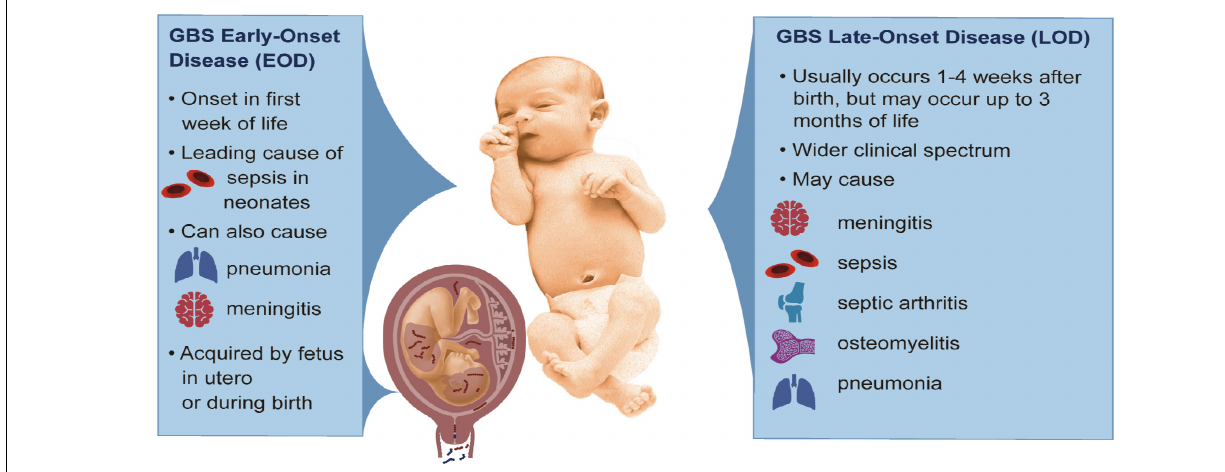
FIGURE 1 | Clinical features of GBS EOD and LOD. The left panel describes characteristics of GBS EOD that arise from acquisition of GBS in utero or during childbirth. The right panel summarizes key features of GBS LOD acquired after birth and includes a wider clinical spectrum of disease. This baby was taken from Creative Commons: